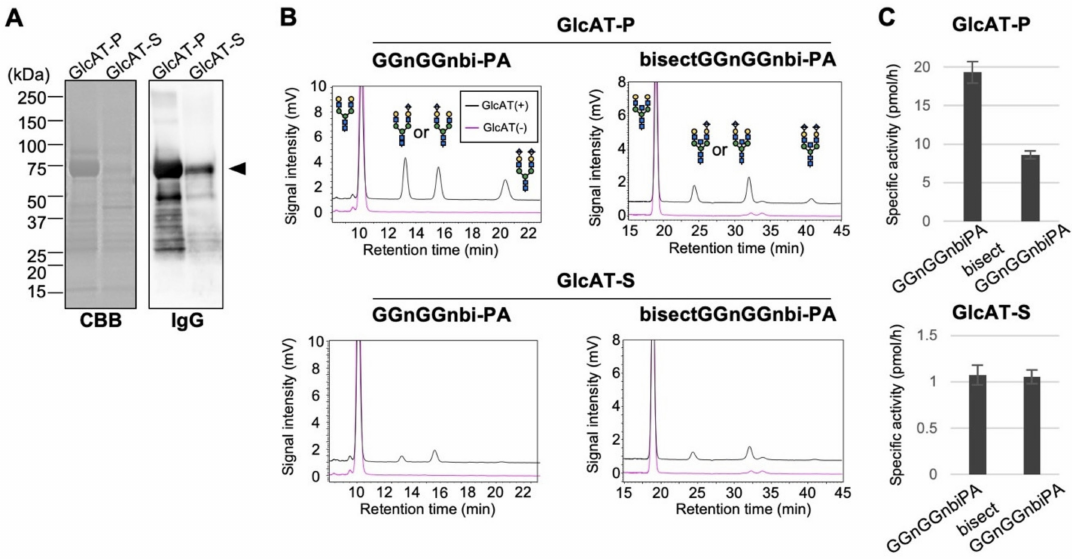
Figure 2. In vitro activity assay of GlcAT-P and GlcAT-S. ( A ) ProteinA-tagged GlcAT-P and GlcAT-S, which were expressed in COS7 cells and purified from the culture media, were subjected to CBB staining and Western blotting with HRP-conjugated IgG. ( B ) Purified GlcAT-P or GlcAT-S was incubated with the PA-labeled non-bisected (GGnGGnbi-PA) or the bisected (bisectGGnGGnbi-PA) acceptor glycan. The reaction mixtures were analyzed by reverse-phase HPLC. Amounts of the product having two GlcA residues eluted most slowly are smaller than the other two products, as in the case for other glycosyltransferases acting on N -glycan terminals [20]. ( C ) The peak areas in ( B ) were quantified, and the specific activity of GlcAT-P and GlcAT-S was calculated ( n = 3). The graphs show means ±